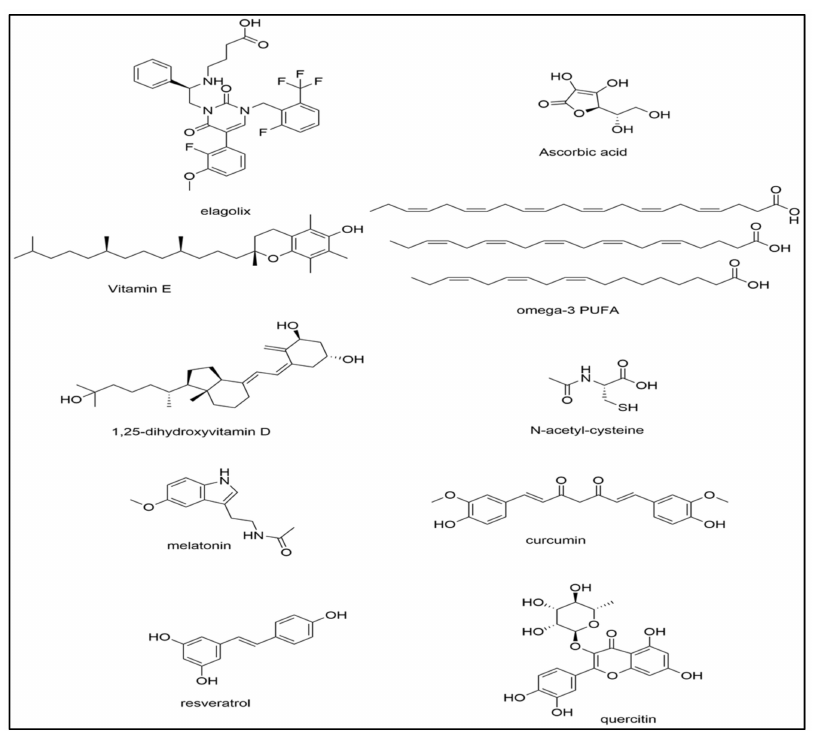
Figure 3. The chemical structures of several key compounds discussed in the review which have been used for the treatment of